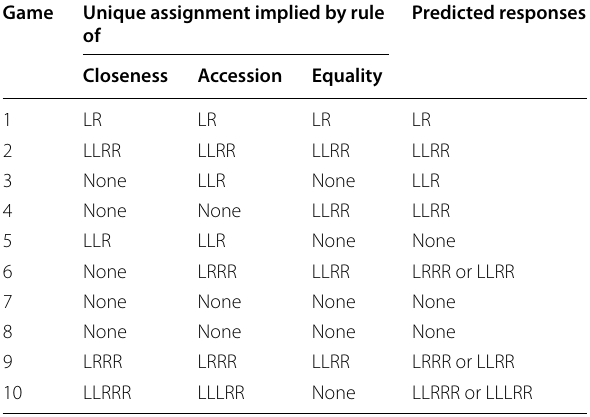
Table 5 Implication of the main selection rules “R” to the right square. The circles are ordered from left to right and from top to bottom. For example, in Game Unique assignment implied by rule Predicted game #3 the assignment implied by the rule of acces- of sion denoted by “LLR”, means that the two bottom cir- cles are connected to the left square and that the upper circle is connected to the right square.